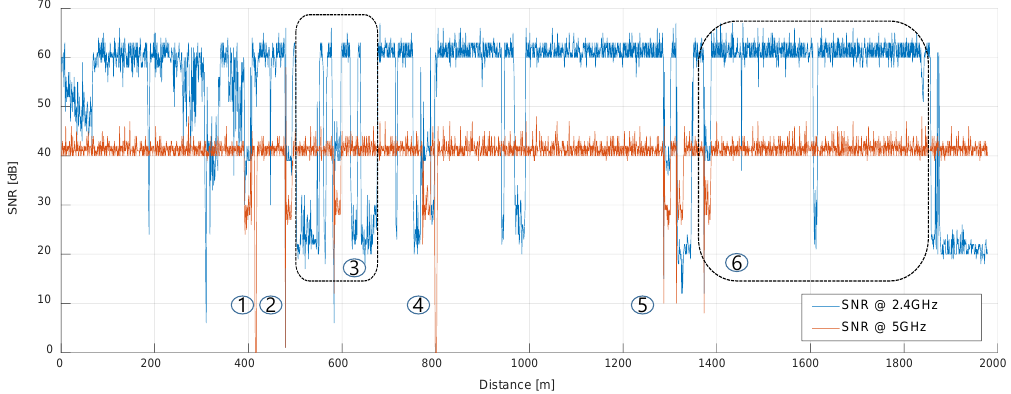
Figure 5. SNR in the test section.